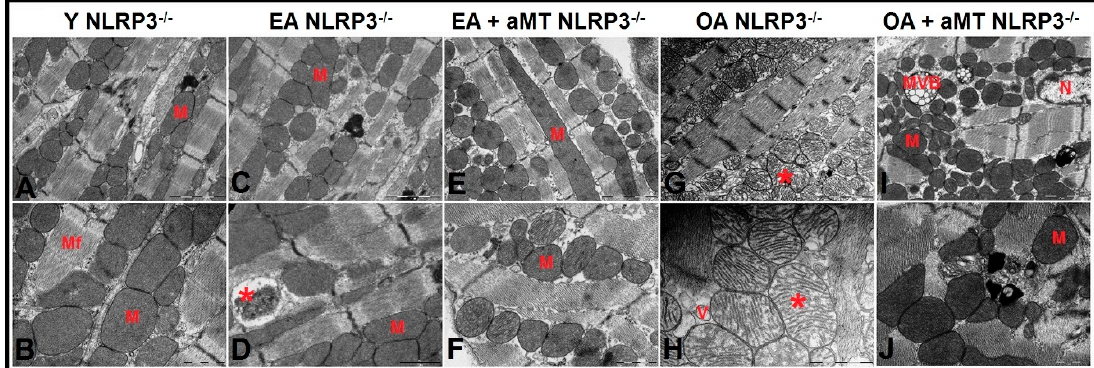
Figure 6. Age-associated ultrastructural changes of mitochondria in cardiac muscle fibers of WT mice and melatonin treatment. ( A , B ) Electron micrographs of cardiac muscle fibers of Y WT mice revealing the presence of normally intact and compacted mitochondria (M) distributed among myofibrils (Mf). ( C , D ) Electron micrographs of cardiac muscle fibers of EA WT mice demonstrating the presence of normal mitochondria (M) with few demonstrating cristae damage (asterisk). ( E , F ) Electron micrographs of cardiac muscle fibers of EA + aMT WT mice showing the protective effect of melatonin supplementation in preserving normal mitochondrial structure (M) with the presence of lipid droplets (L), N; nucleus. ( G , H ) Electron micrographs of cardiac muscle fibers of OA WT mice clarifying the presence of numerous severely damaged hypertrophied vacuolated mitochondria with completely destructed cristae (asterisk). ( I , J ) Electron micrographs of cardiac muscle fibers of OA + aMT WT mice exhibiting the beneficial effect of melatonin supplementation in keeping normal mitochondrial architecture (M). ( A , C , E , G , I ): bar = 2 μ m and ( B , D , F , H , J ): bar = 1 μ m. Cardiac muscle fibers of NLRP3 − / − Y mice presented normal highly compacted mitochondria with densely packed cristae (Figure 7A,B). Mitochondrial structure did not change in EA mice, except